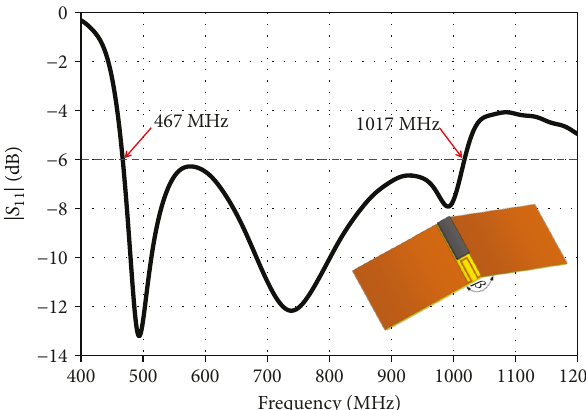
Figure 3: Simulated | S | of the proposed meander line antenna 11 without MD (non-MD